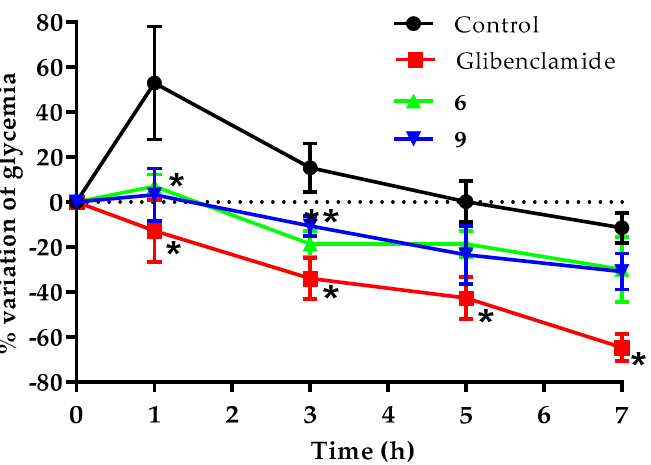
Figure 4. Effect of a single dose of 6 and 9 over the blood glucose in STZ-NA-induced diabetic mice. * Statistically significant difference versus control group by multiple comparison Dunnett’s test. Glibenclamide was administered at 20 mg/kg. Compounds were administered at 100 mg/kg ( n = 6, mean ± SEM, p < 0.05).